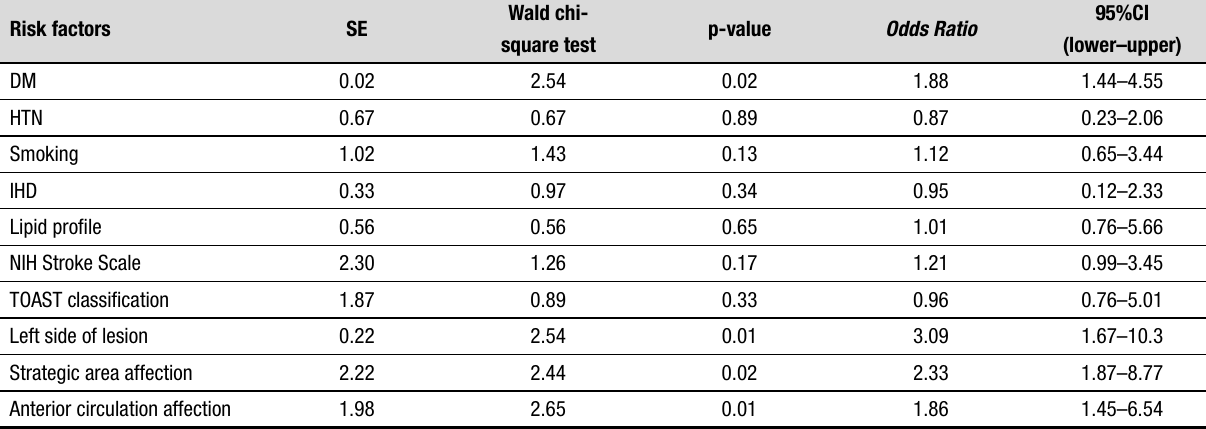
Table 4. Binary logistic regression analysis for independent risk factors of dementia among stroke patients. Risk factors SE